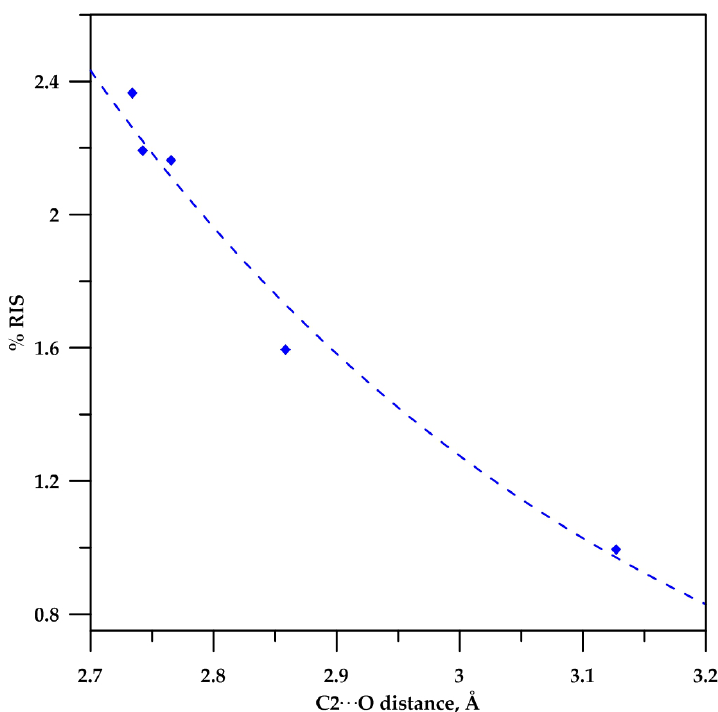
Figure 5. Correlation of %RIS for C − H bond with C2···O distance donor–acceptor. %RIS = Correlation of %RIS for C − H bond with C2 ··· O distance donor–acceptor. 813.64Exp( − 2.153*distance), R 2 = 0.9806.